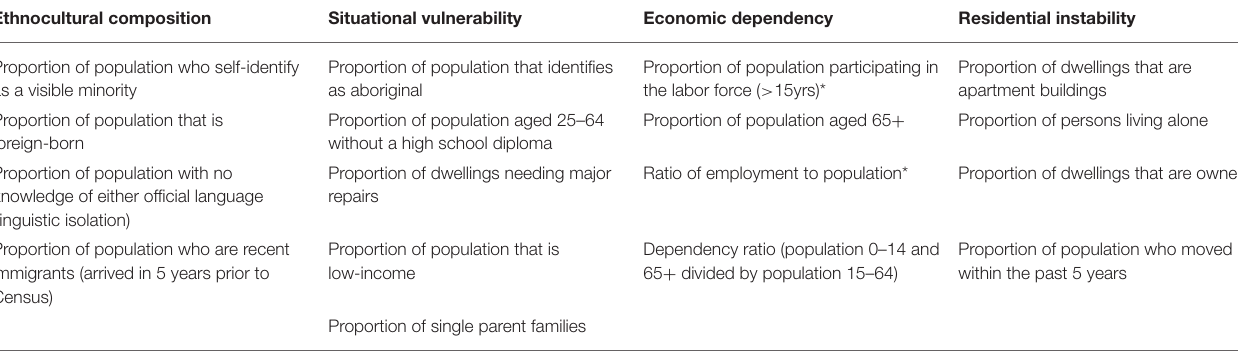
TABLE 1 | The four dimensions of multiple deprivation and corresponding indicators for British Columbia